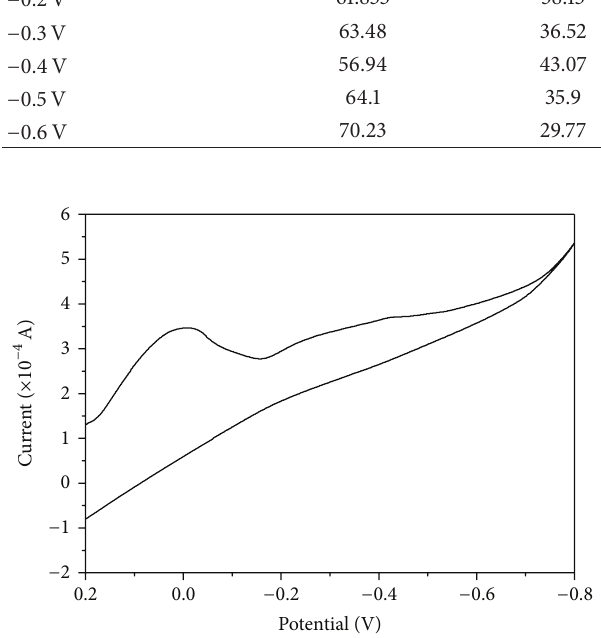
Figure 3: Cyclic voltammetry curve of 0.3 M KI, 0.01 M Bi 3+ , and 0.01 M Te 4+ in ethylene glycol.